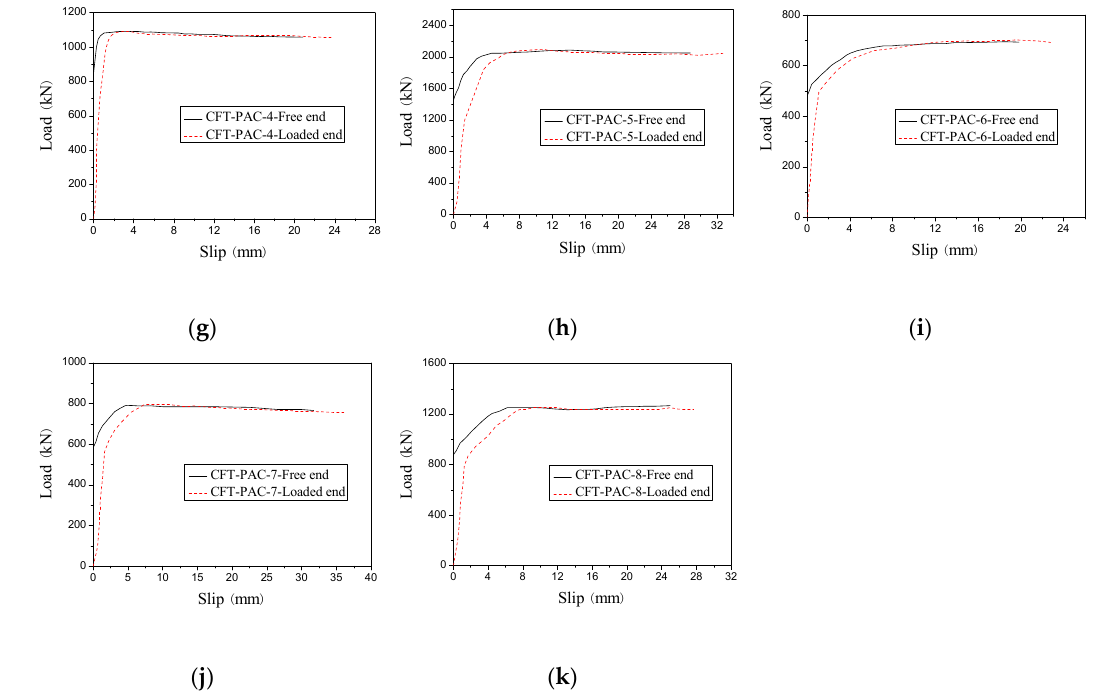
Figure 6. Load-slip curves at loading end and free end for specimens. ( a ) CFT-NC-1; ( b ) CFT-NC-2; ( c ) CFT-NC-3; ( d ) CFT-PAC-1; ( e ) CFT-PAC-2; ( f ) CFT-PAC-3; ( g ) CFT-PAC-4; ( h ) CFT-PAC-5; ( i )